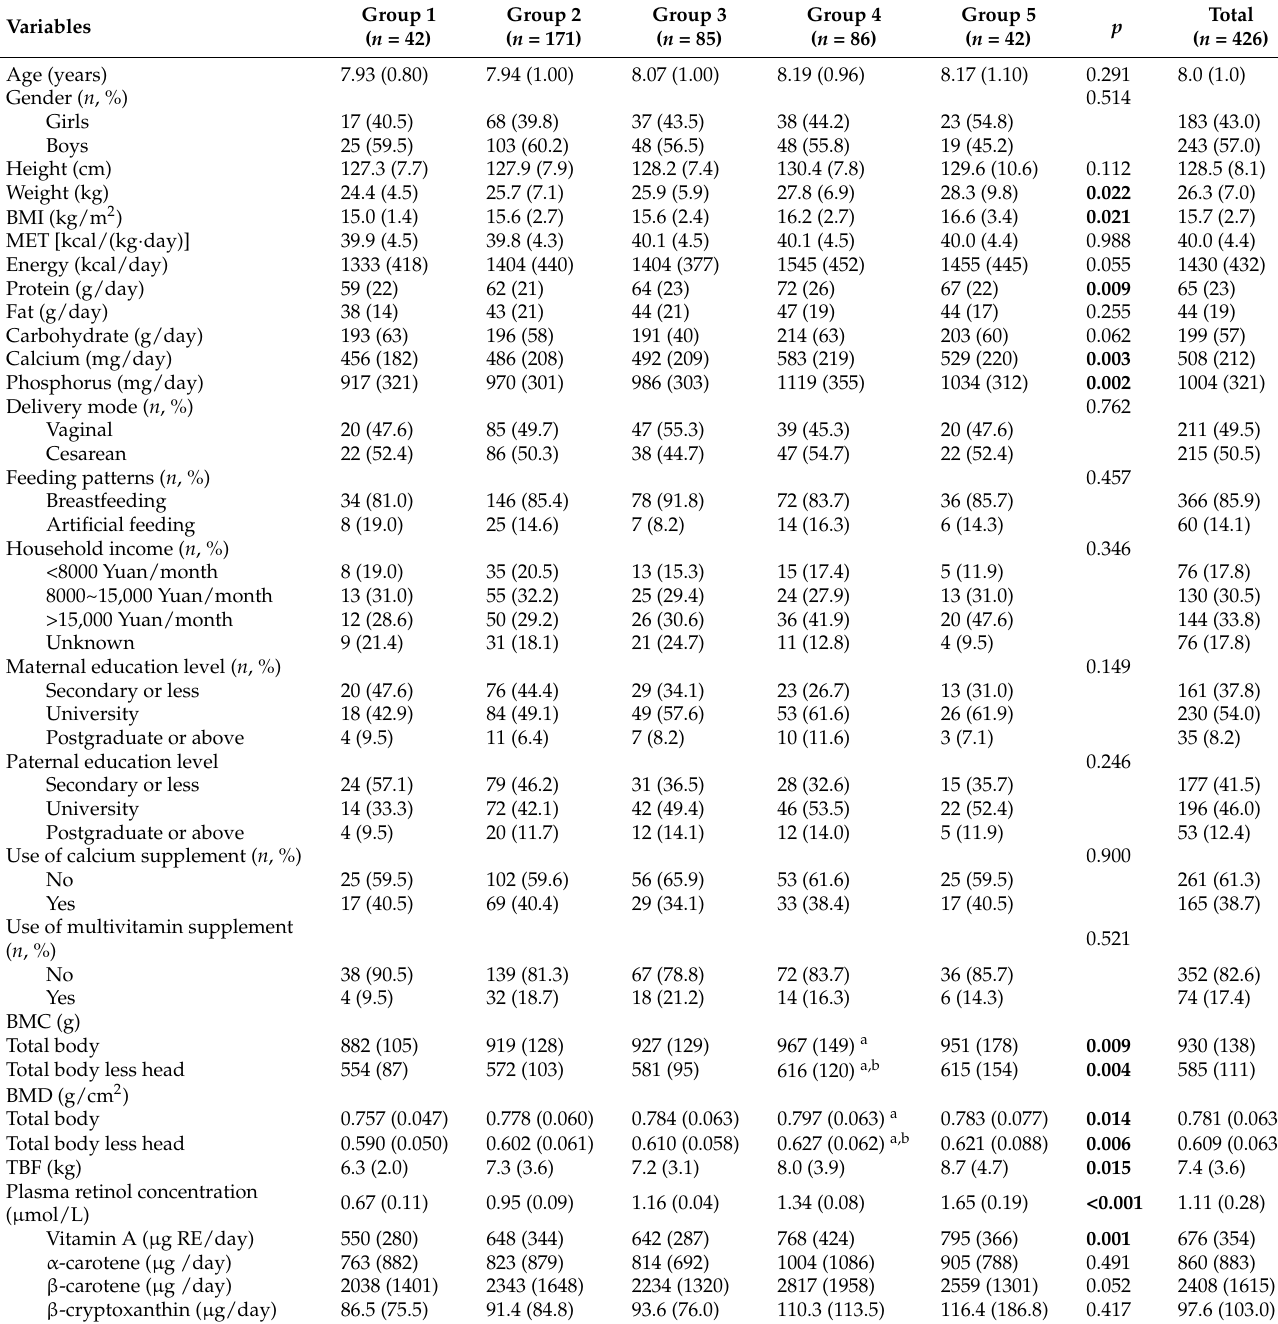
Table 1. Characteristics of 426 participants divided by knots of 10th, 50th, 70th and 90th centiles of plasma retinol